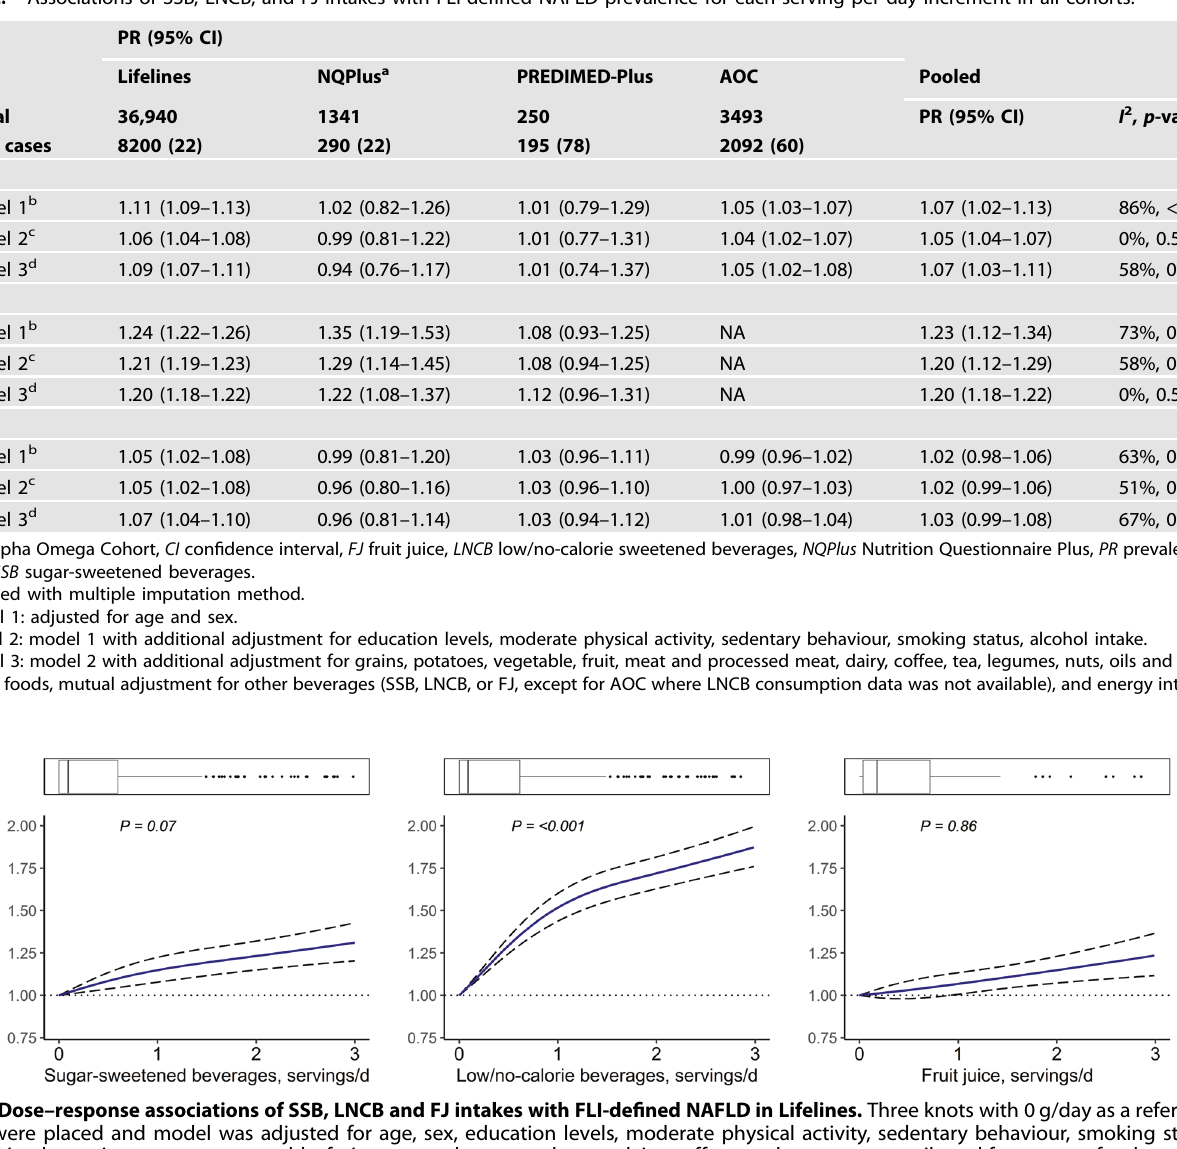
Table 2. Associations of SSB, LNCB, and FJ intakes with FLI-de fi ned NAFLD prevalence for each serving per day increment in all cohorts.